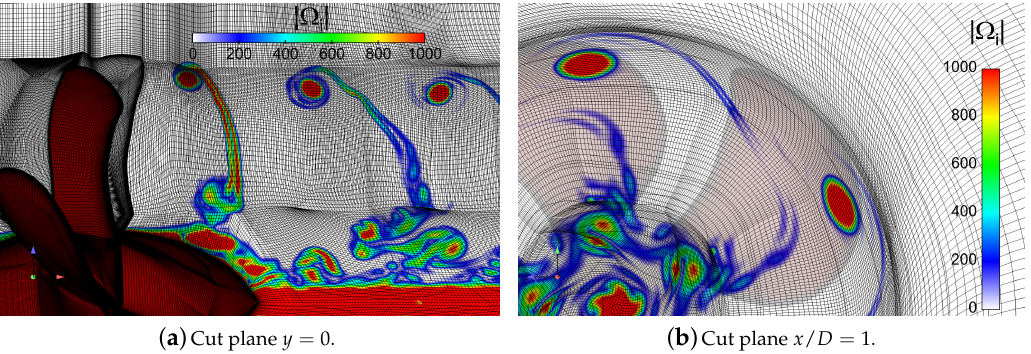
( a ) Cut plane y = 0. Figure 5. Views of grid resolution on cut planes y = 0 and x / D =